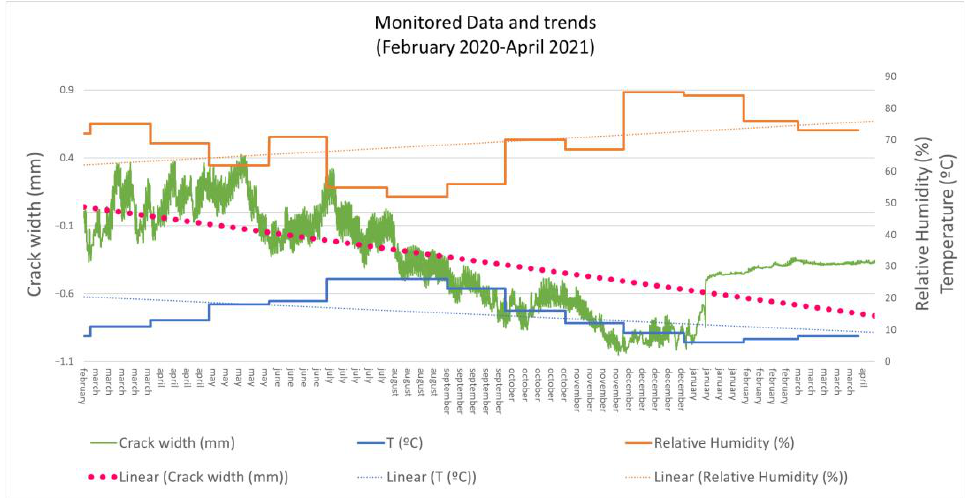
Figure 11. Graph showing variation in monitored parameters from February 2020 to April 2021. Positive values indicate that the crack has closed since the beginning of the monitoring, and negative values indicate that the crack has opened.